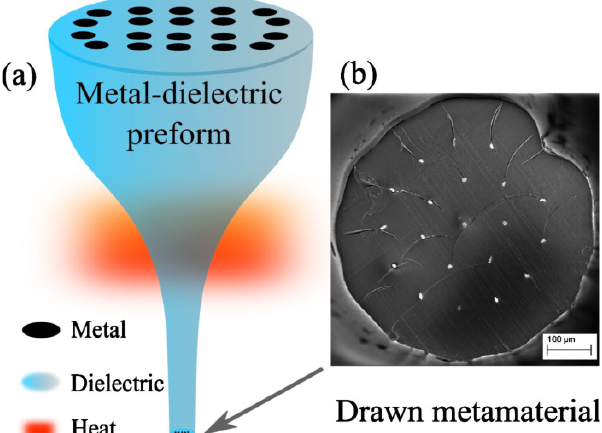
Figure 6. ( a ) schematic of a metal-dielectric preform, drawn into a metamaterial via heating; ( b ) SEM micrograph of a fabricated 590 µm indium-filled PMMA fiber cross-section, reprinted with permission from